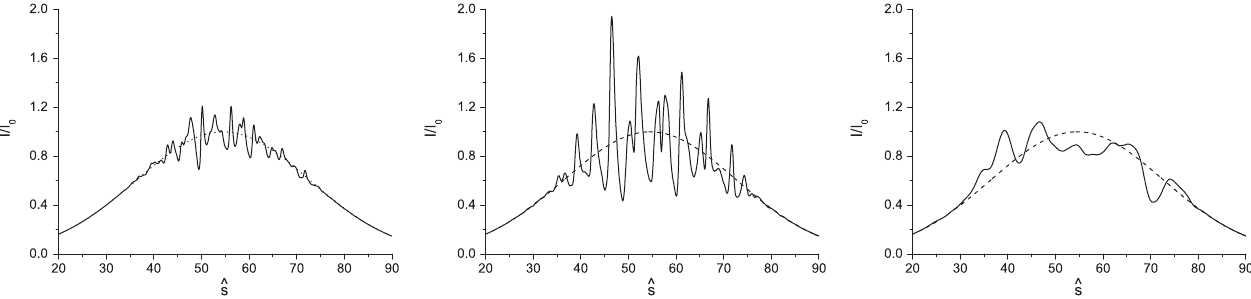
¼ 5 (right). The undisturbed energy spread is ^(cid:1) 56